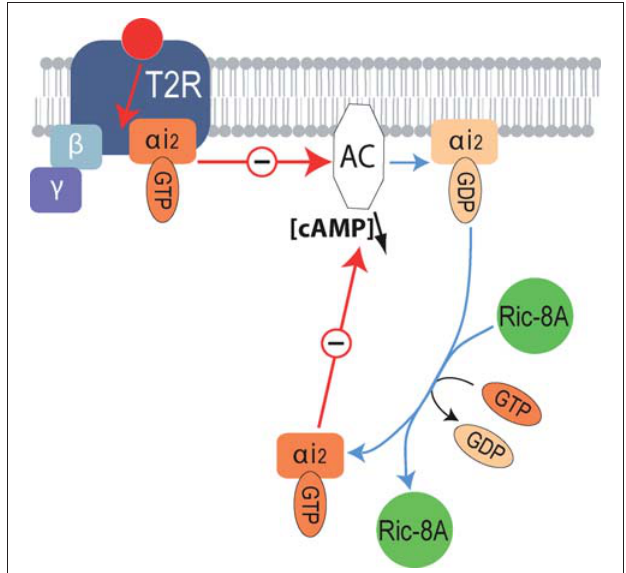
FIGURE 6 | Molecular mechanisms underlying the modulation of bitter receptor signaling by Ric-8A. Diagram illustrating the signaling cascade downstream of bitter taste GPCR (T2R) modulated by Ric-8A. Upon activation of T2R the receptor coupled heterotrimeric G-protein separates into G α -GTP and G βγ , G α -GTP will then inhibit the activity of adenylyl cyclase, subsequently the GTP bound to G α will be hydrolyzed into GDP, G α -GDP can then reassociate with G γβ or interact with Ric-8A. By supporting the exchange of GDP by GTP, the GEF activity of Ric-8A will allow a new cycle of inhibition of the effector thus enhancing the